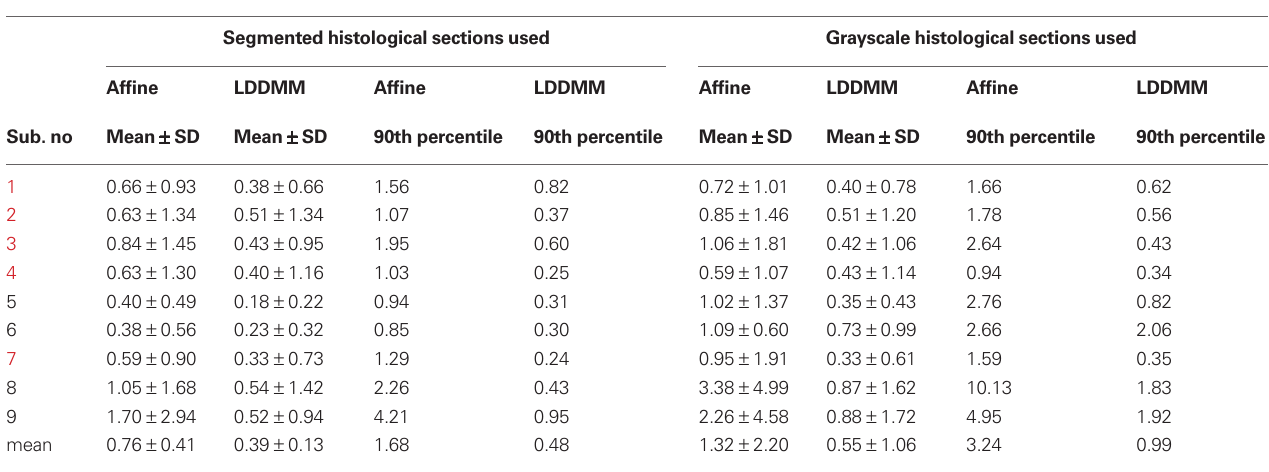
Table 2 | gM/CSF surface distance errors (mm). Segmented histological sections